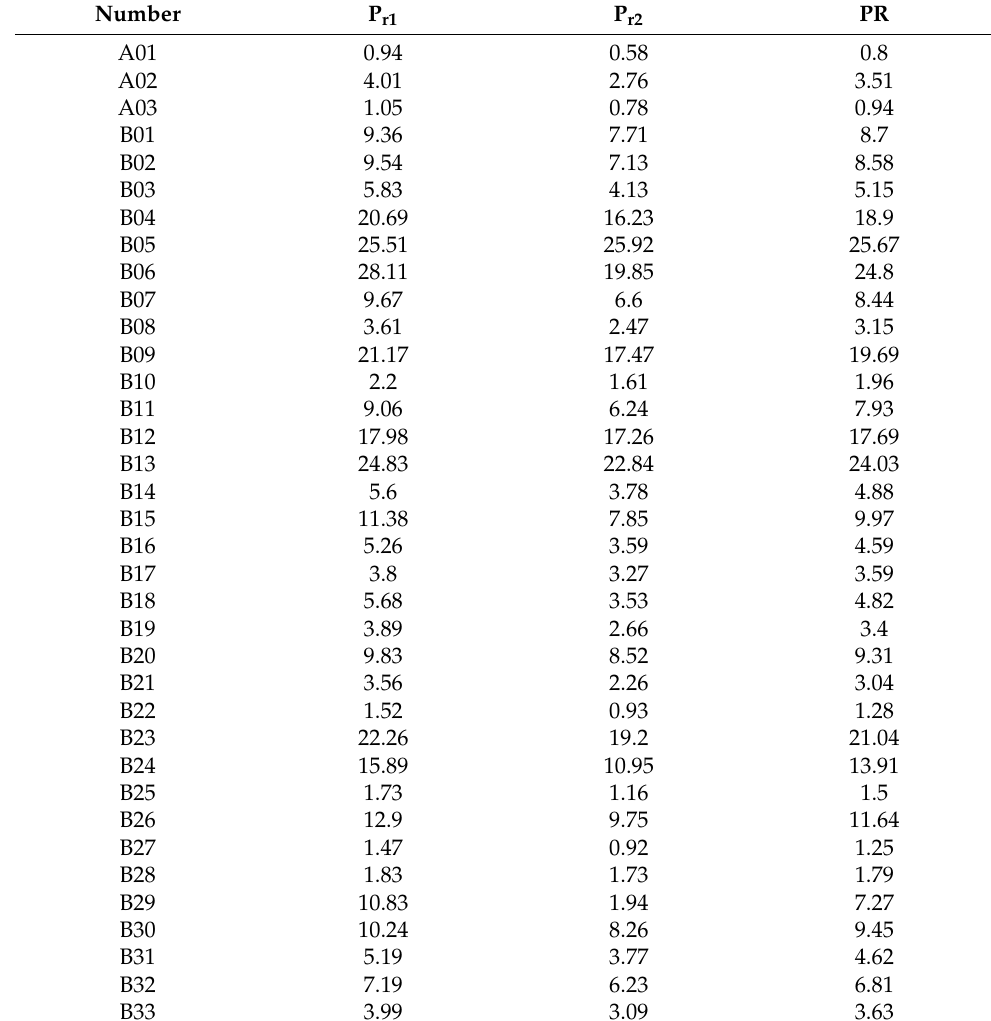
Table 3. The predicted resources of the prediction areas ( × 10 4